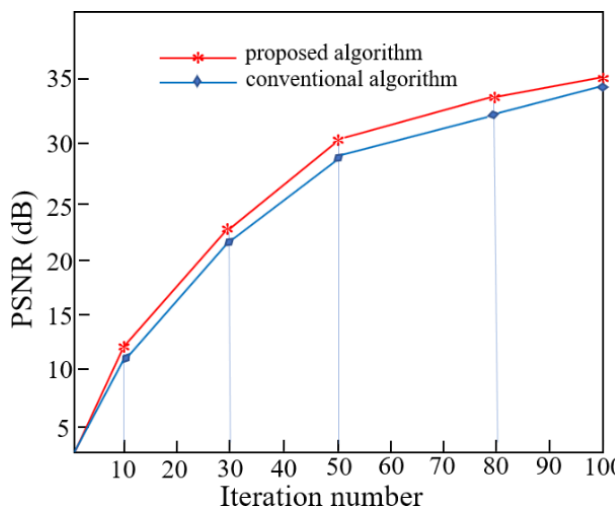
Figure 8. Peak signal-to-noise ratio (PSNR) comparison for visual quality evaluation.